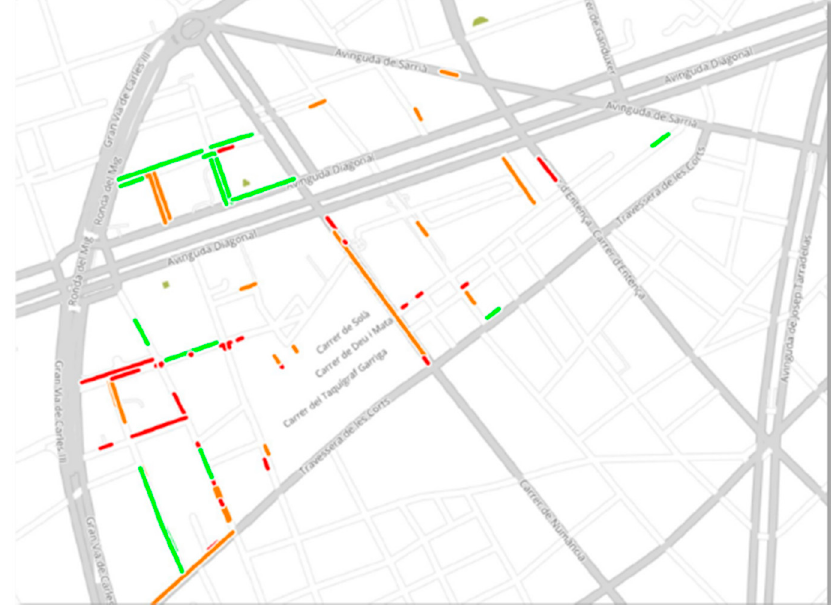
Figure 9. Parking detectors distribution in Barcelona.